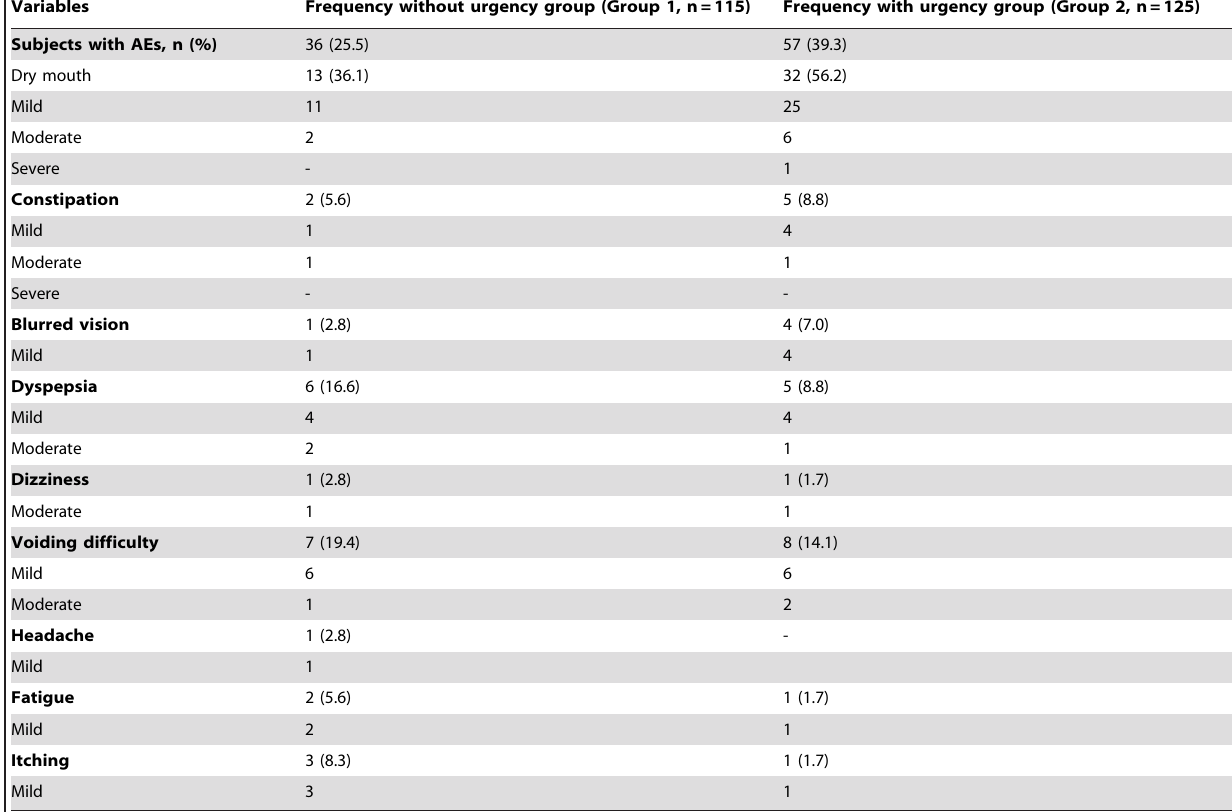
Table 4. Treatment-emergent adverse events in both